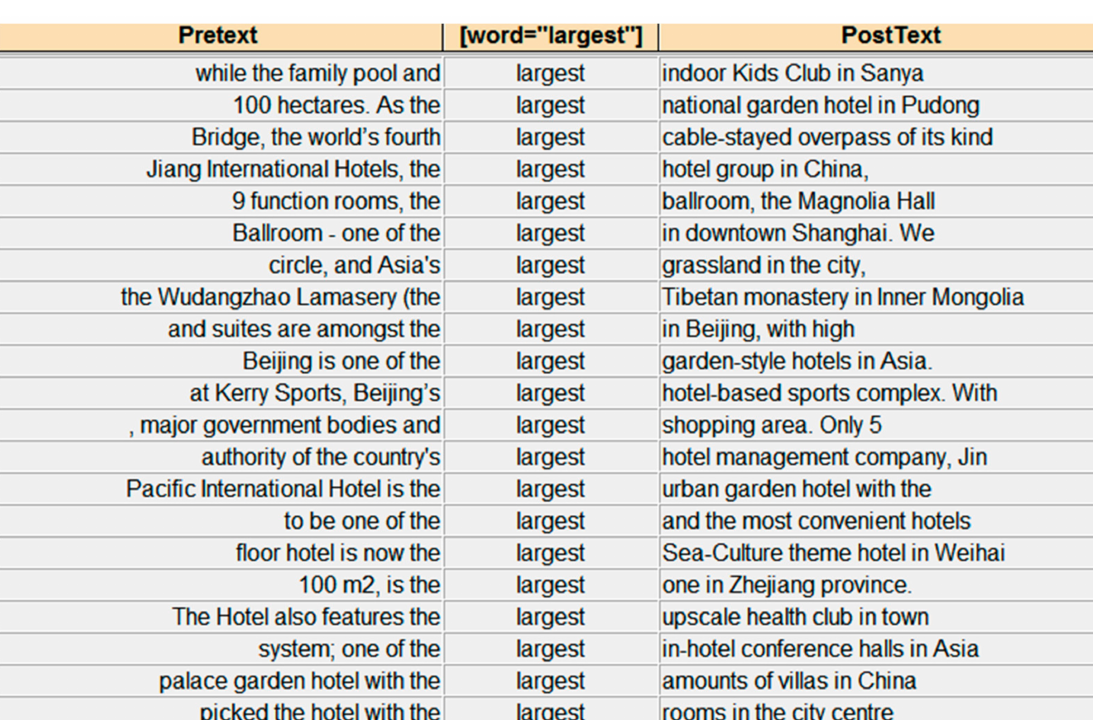
Figure 4. Examples of the use of “view” in prestige.